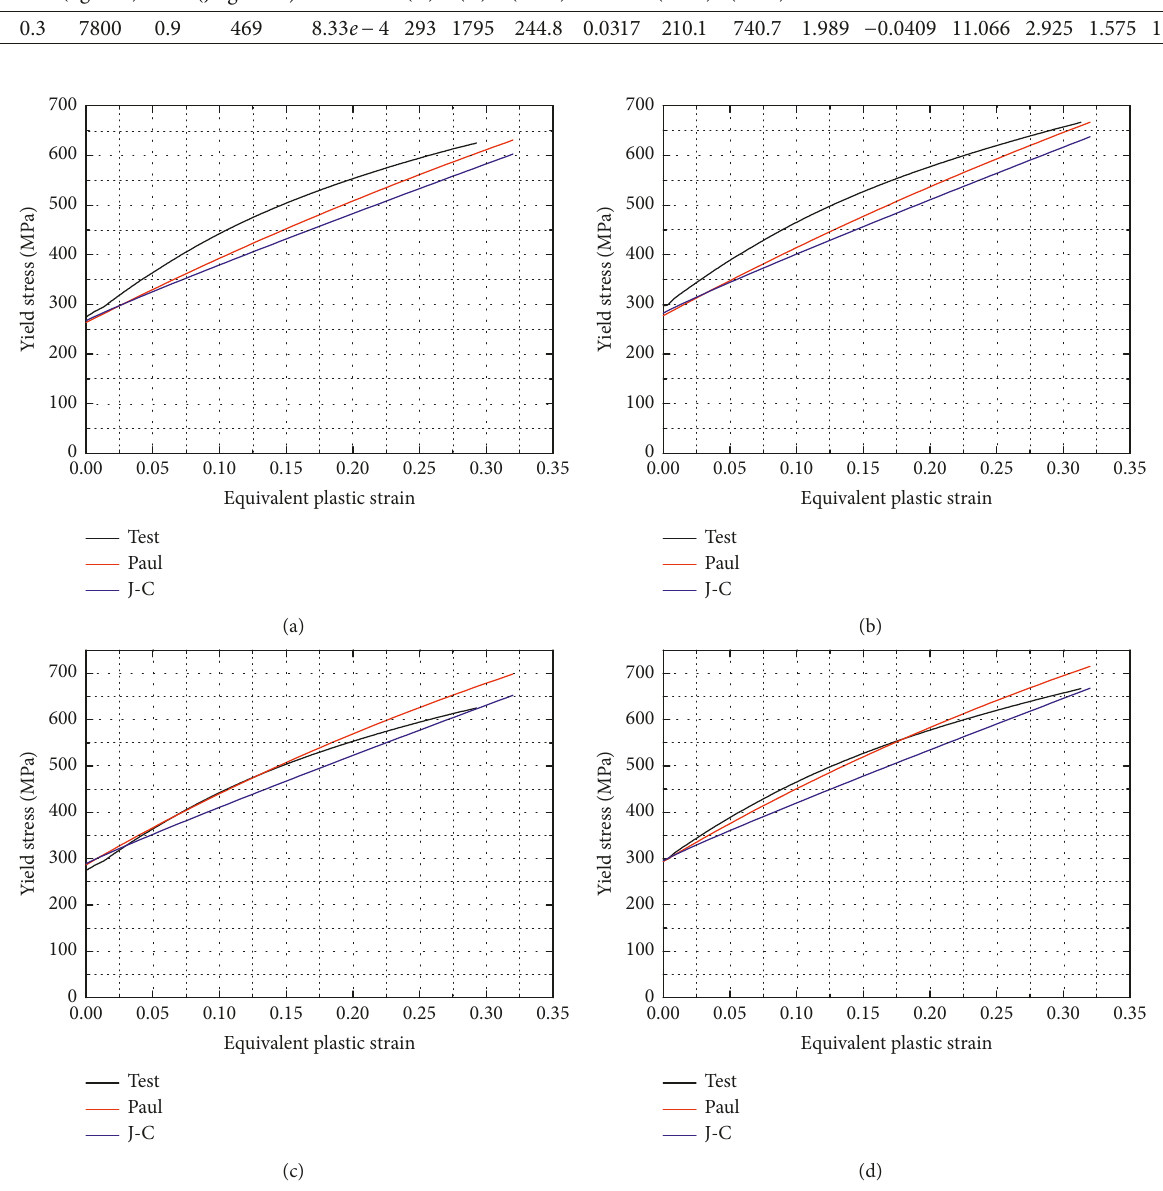
Figure 5: Flow curve at different strain rates. (a) 10 mm/min. (b) 50mm/min. (c) 100mm/min. (d)